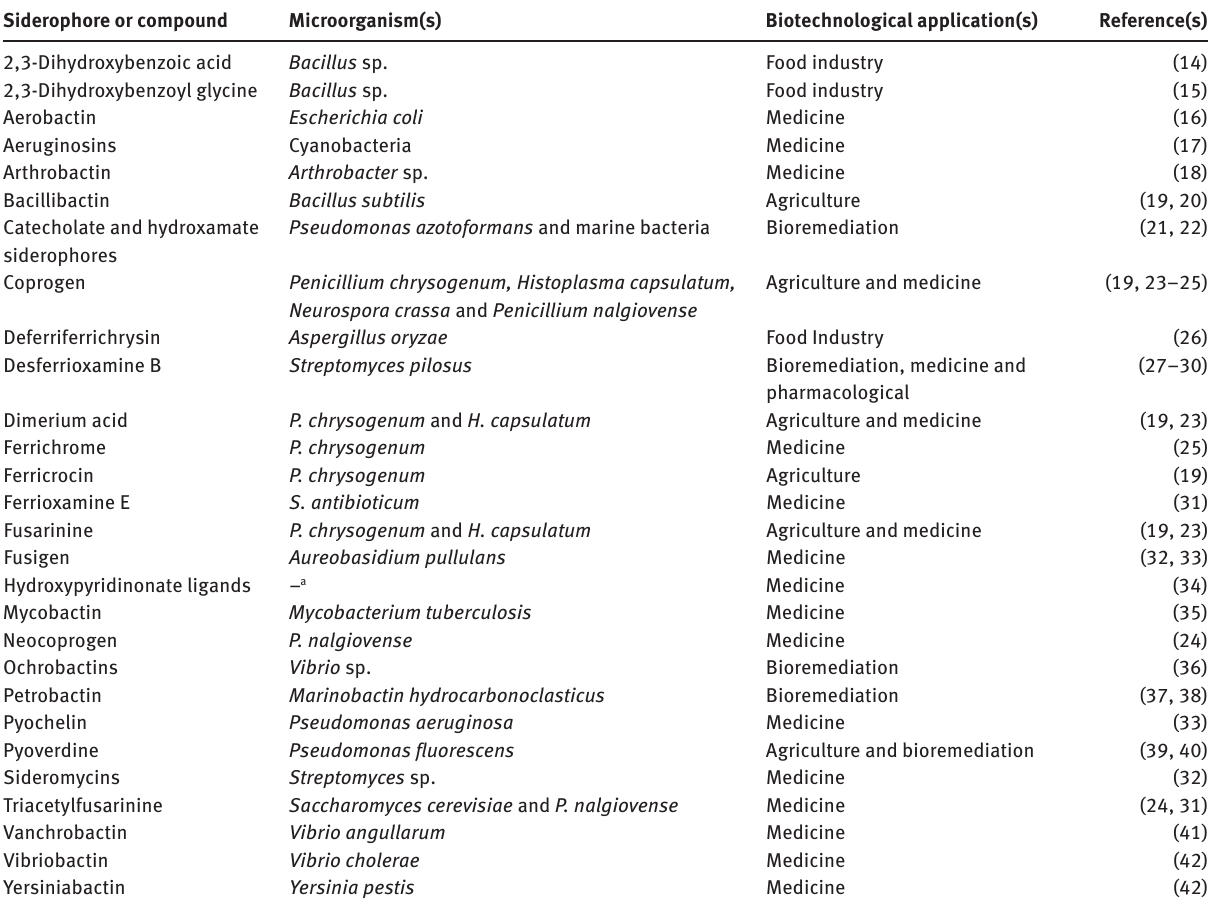
Table 1: Overview of siderophores discussed and applied in different high-impact scientific areas. Siderophore or compound